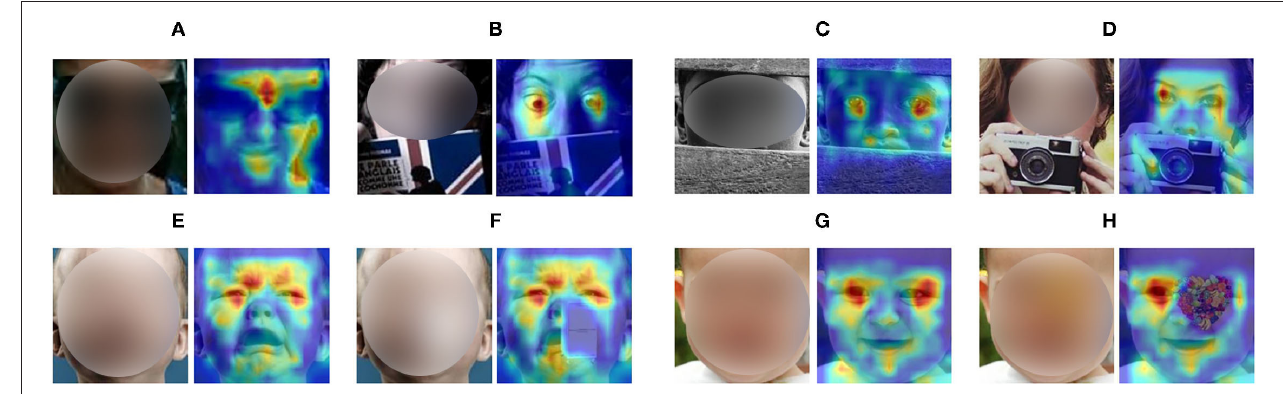
FIGURE 1 | Attention maps of several facial images with real ( A–D in top row) or synthesized ( E–H in bottom row) occlusions. Our proposed TFE is capable of perceiving the important facial regions for robust FER. A deep red means high attention. Better viewed in color and zoom